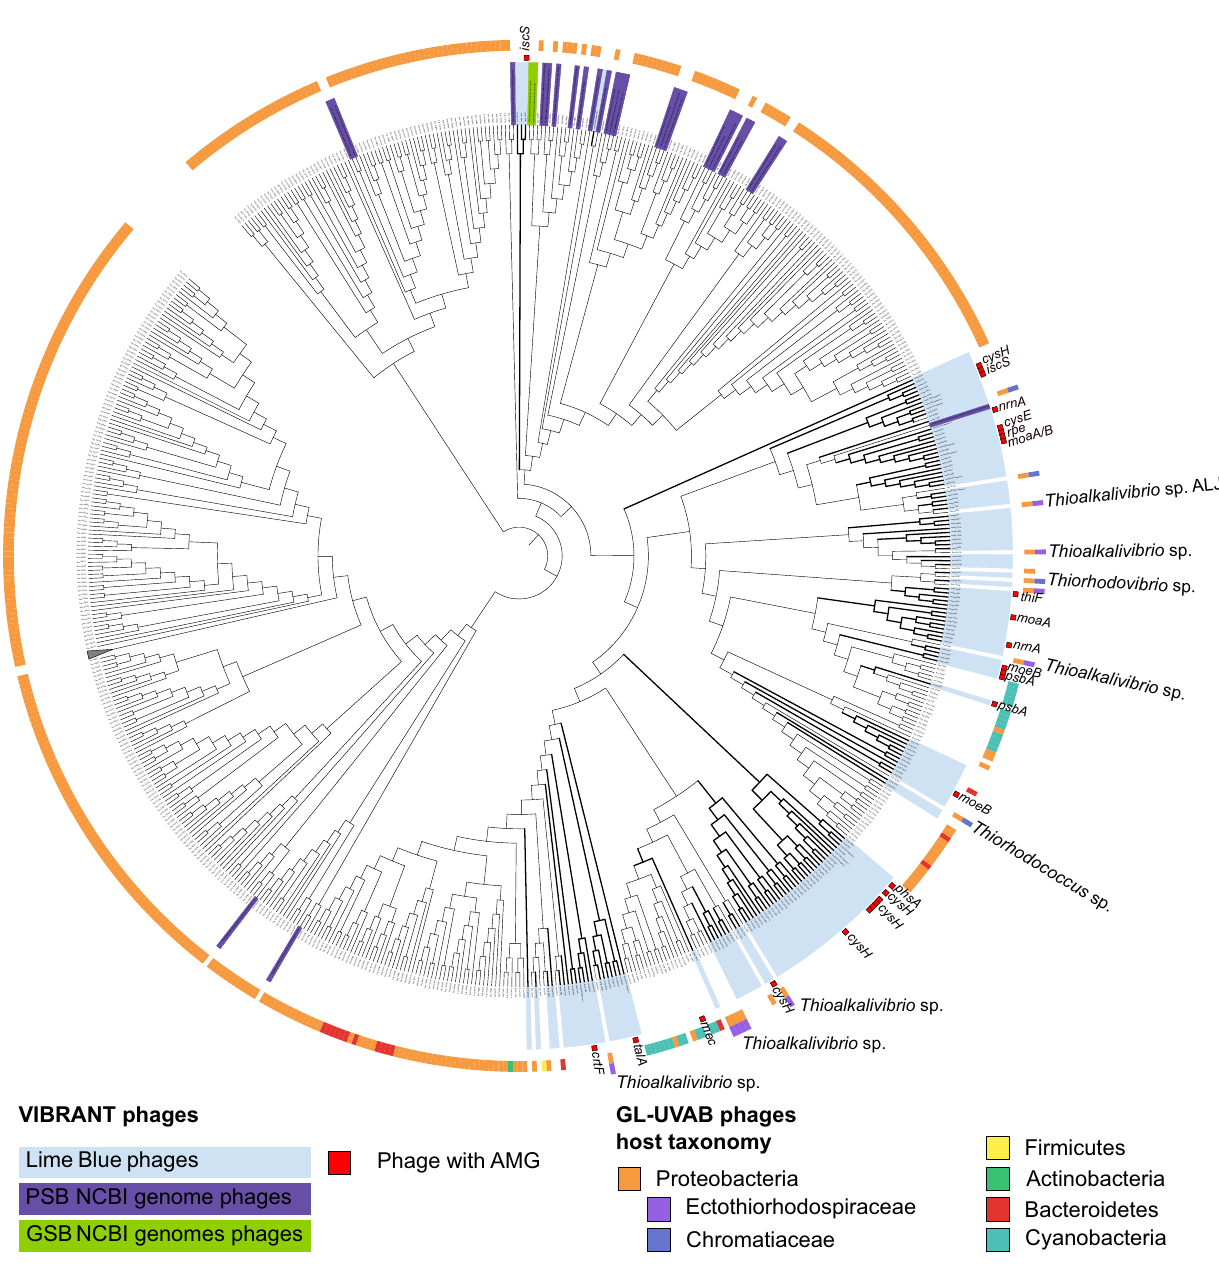
Fig. 2 Phylogenomics of Lime Blue phages, phages identi fi ed in cultured PSB and GSB genomes from the NCBI RefSeq, and phages from the GL-UVAB database. The VIBRANT phages from Lime Blue, many of which contained AMGs of interest (inner ring), form branches with low similarity to reference phage genomes (light blue branches). Where known, the host genus of the reference PSB-infecting phage was indicated (outer ring). The branch lengths are ignored to better display clustering topology. For a version displaying branch length, see Supplementary Fig.